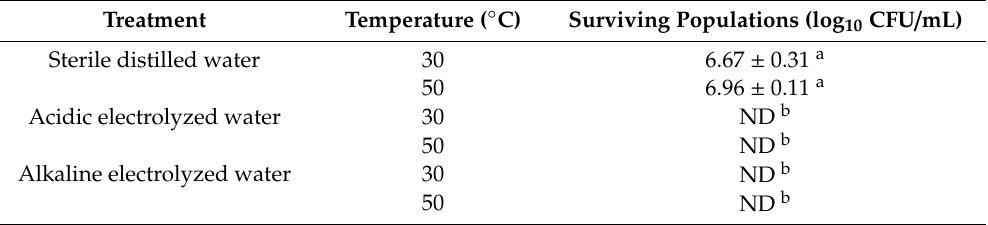
Table 15. E ff ect of di ff erent cleaning treatment in disinfecting Escherichia coli ATCC